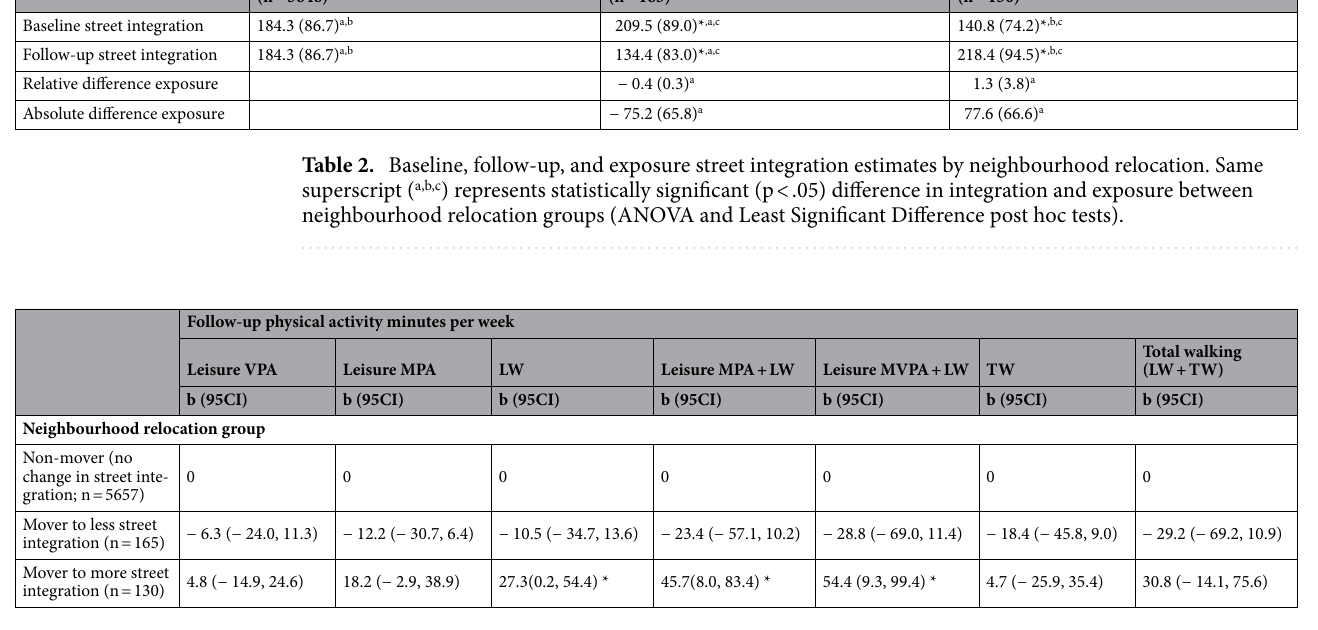
Table 3. Differences in follow-up weekly physical activity minutes a among movers to lower and higher street integration compared with non-movers. Unstandardized beta (b) coefficients represent mean difference in physical activity relative to non-movers, adjusted for baseline sex, age, children, education, income,